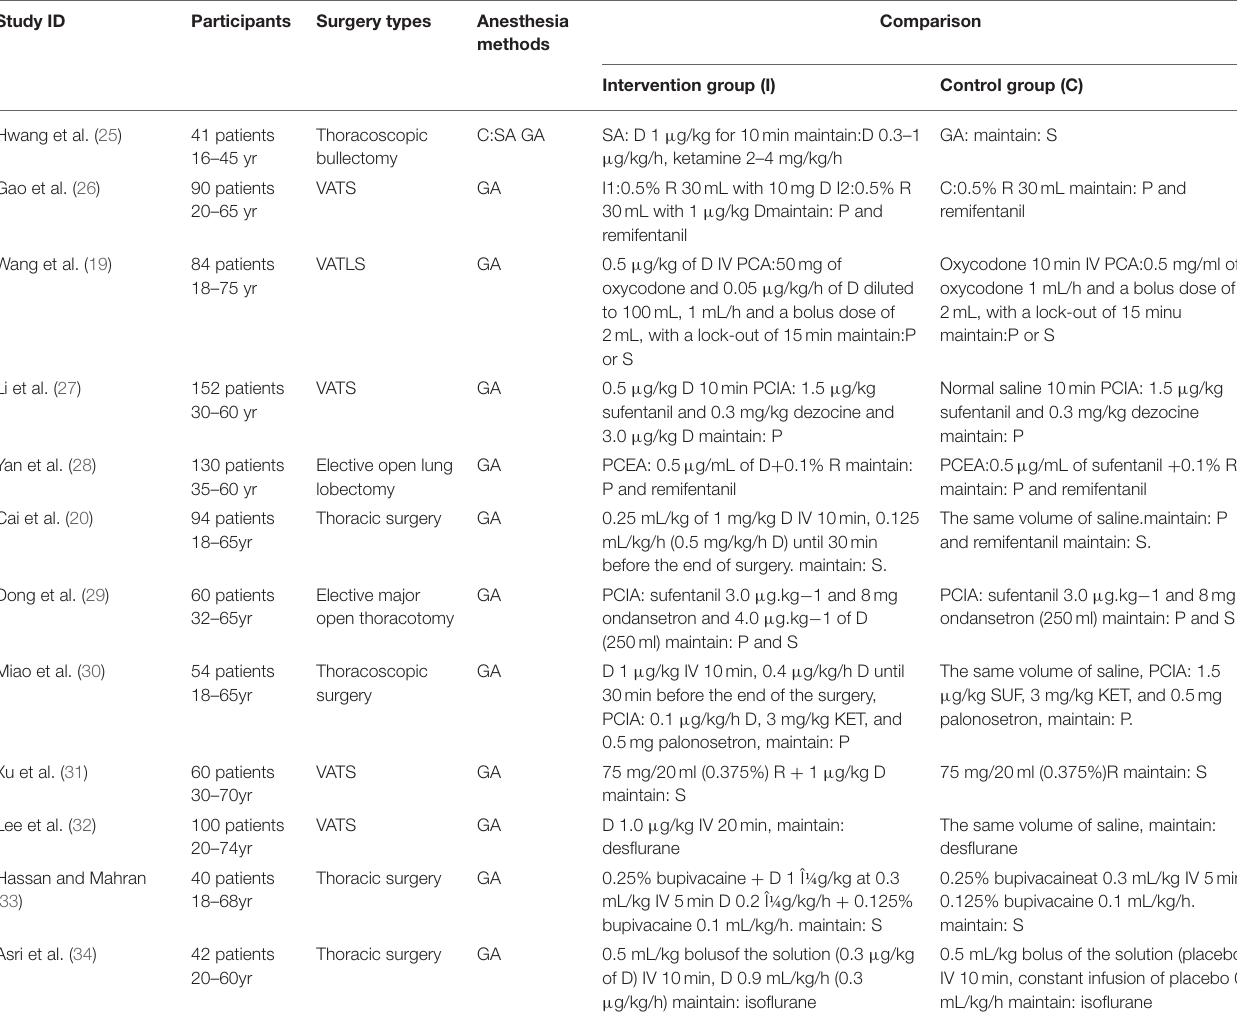
TABLE 1 | Characteristics of included